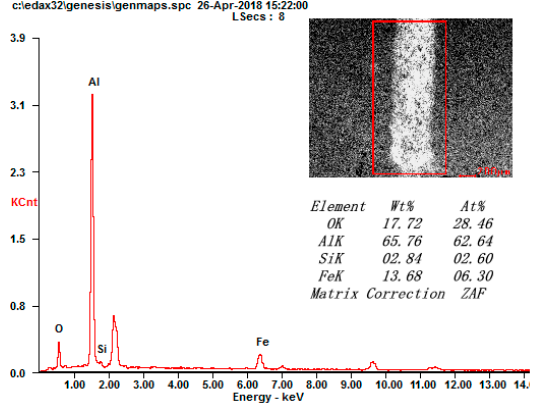
Figure 8. EDS analysis of the grinding crack surface.